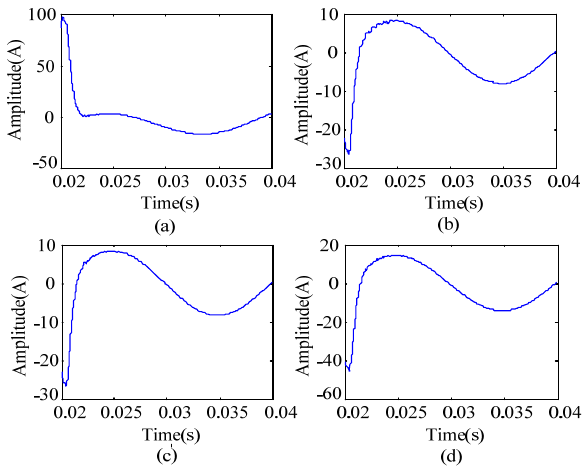
Figure 8. IMF1 components of each outgoing line. ( a ) Lian L 1 ; ( b ) Lian L 2 ; ( c ) Lian L 3 ; ( d ) Lian L 4 .